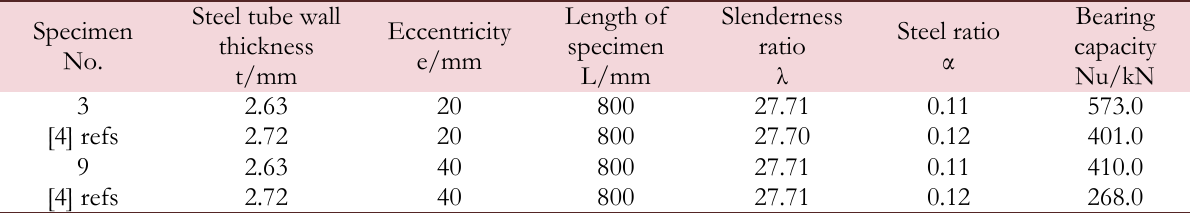
Table 5: Comparison with experimental results in [4]